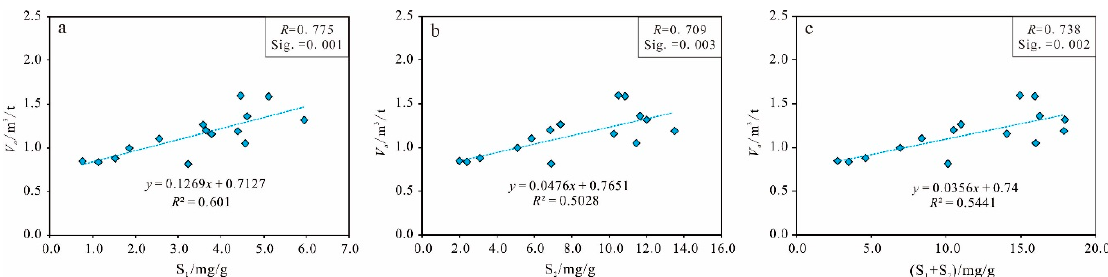
Figure 10. Correlations between V a and pyrolysis parameters. ( a ) Correlations between V a and residual hydrocarbon S 1 ; ( b ) Correlations between V a and pyrolysis hydrocarbon S 2 . ( c ) Correlations between V a and hydrocarbon generating potential (S 1 + S 2 ).